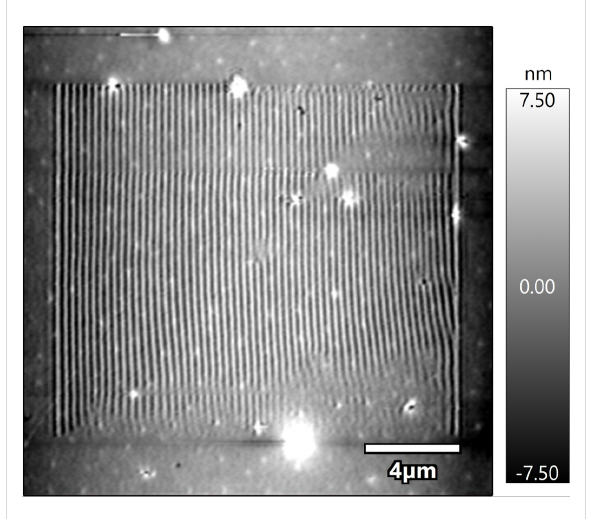
Figure 4: Tapping-mode topography image of a 100 nm thick PnBMA film after a smaller area (15 µm) 2 was scanned in DART mode with a static force of 308 nN, a frequency of ca. 320 kHz, and amplitudes of 440 and 80